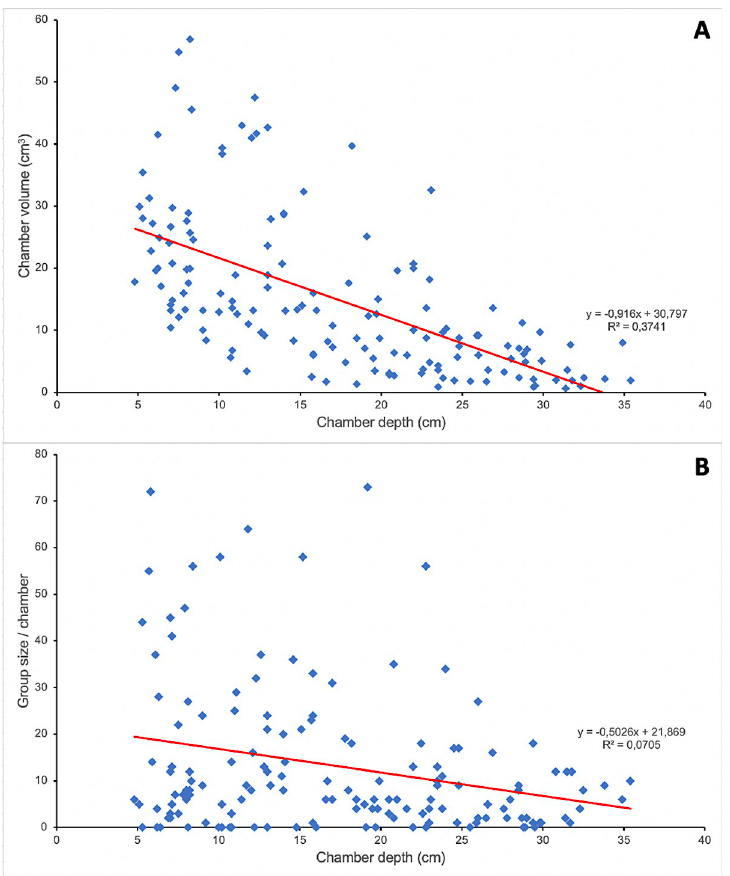
Fig 3. Correlation between chamber depth and (A) chamber volume or (B) group size per chamber. The deeper the chamber, the smaller its volume (R(148) = - 0.6112, p < 0.001) and the number of ‘adults + brood’ per chamber (R (148) = - 0.2656; p = 0.001).